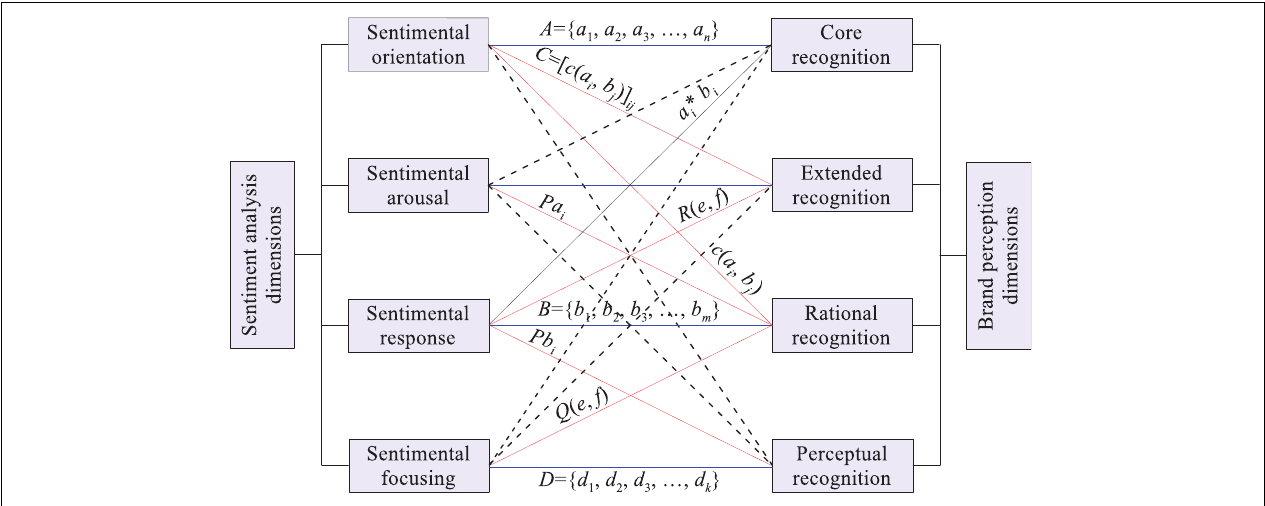
FIGURE 1 | Text quantization and algorithm evaluation in the information receiving hierarchy of the quantitative model of brand recognition based on sentiment analysis of big data.